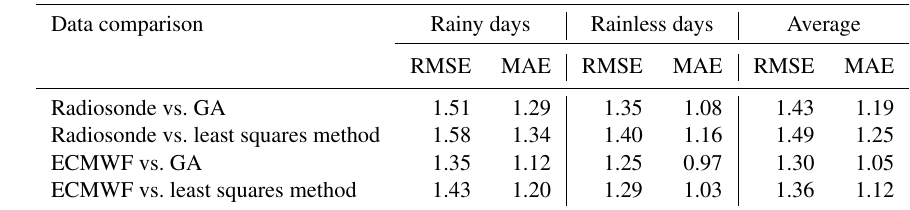
Table 4. Statistical results of the GA and the least squares method using radiosonde and ECMWF data as reference in the selected voxels (gm − 3 ).